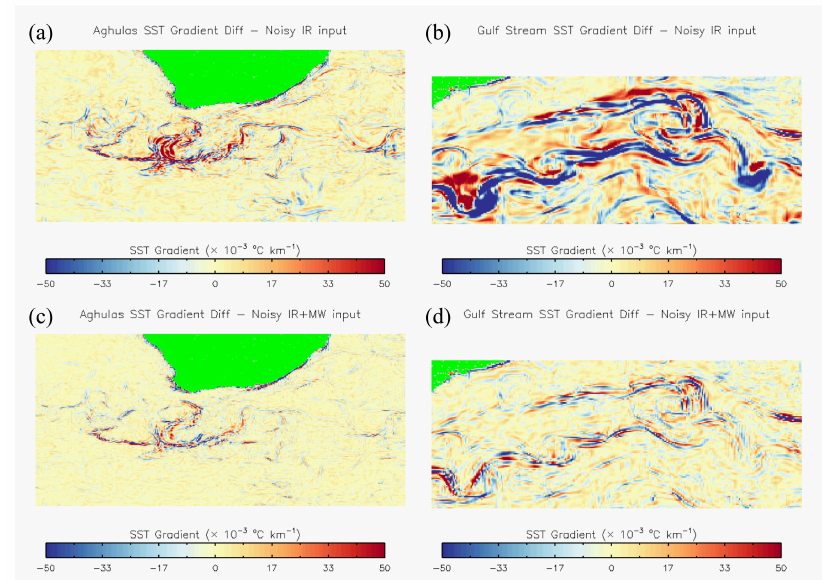
Figure 13. Di ff erence from the “truth” SST gradient field in January for the output of OSTIA reconstructions using input data with realistic errors: ( a ) IR-only data for the Aghulas Current region, ( b ) IR-only data for the Gulf Stream region, ( c ) combined IR and MW data for the Aghulas Current region and ( d ) combined IR and MW data for the Gulf Stream